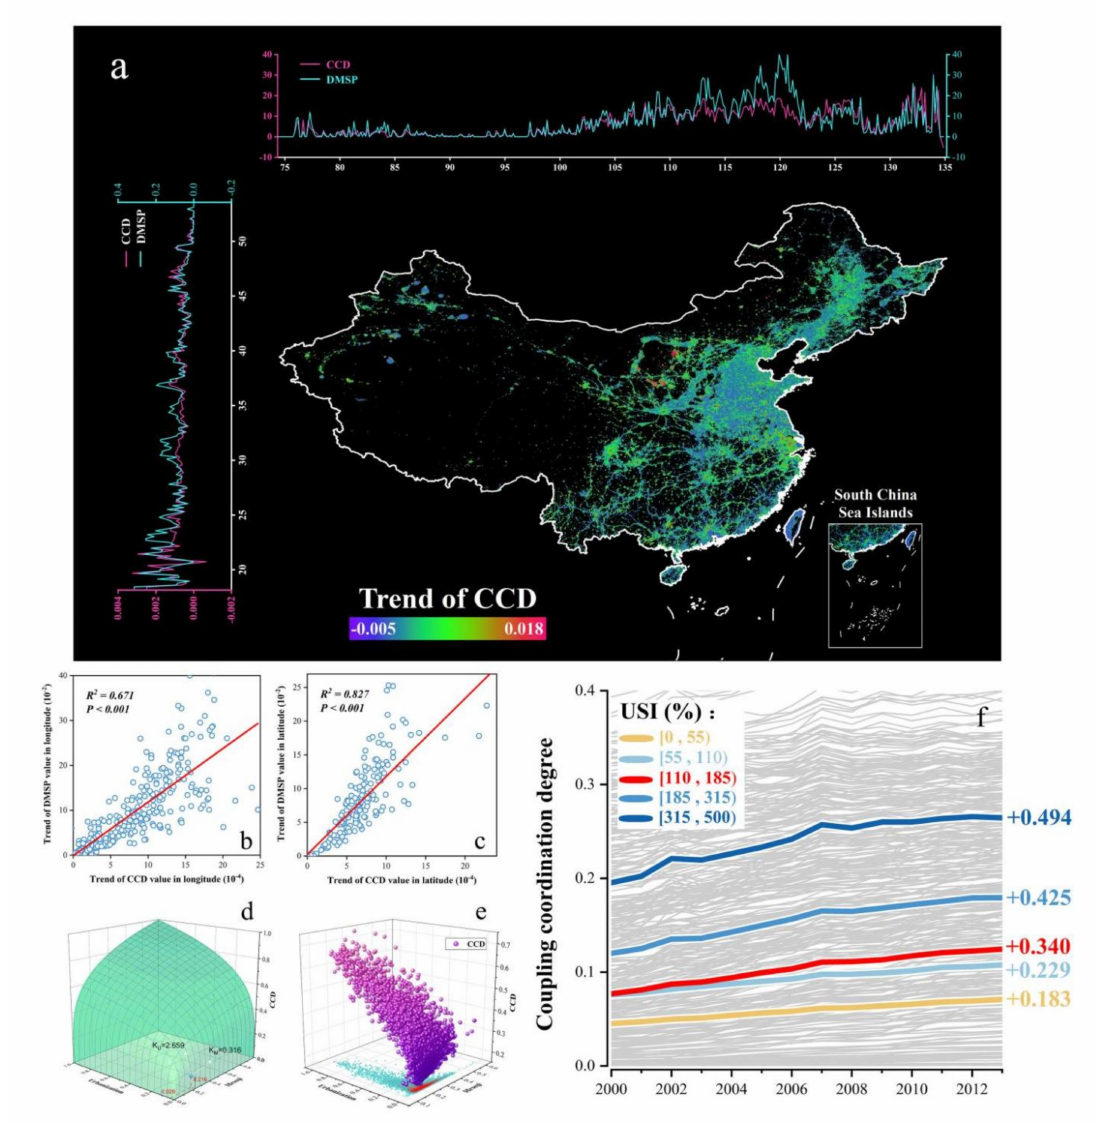
Figure 13. 3D scatter diagram of M-RSEQI, urbanization, and CCD in 2013 and 3D function diagram of the CCD model. ( a ) shows the spatial distribution of the CCD trends in China from 2001 to 2013; ( b , c ) show the correlation between the average trend value of CCD and nighttime light in latitude and longitude; ( d , e ) show that in 2013, the growth rate of the CCD in the urbanization component was 2.659; ( f ) the CCD value of most cities showed a continuous upward trend (gray broken